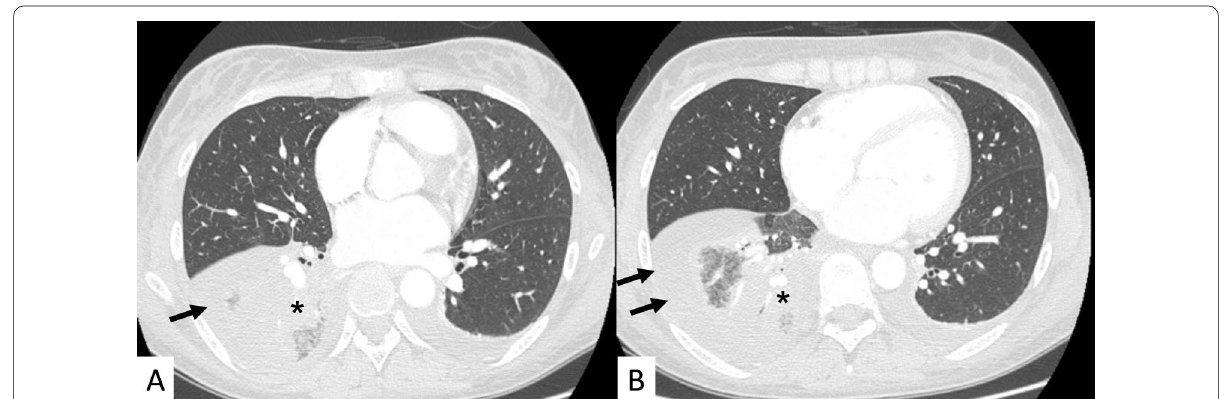
Fig. 21 A 37-year-old patient with ALP, characterized by dyspnea, fever and pleuritic pain; on HRCT images ( A , B ), bilateral pleural effusions (black arrows) and right lower lobe consolidation (black asterisk) are clearly recognizable